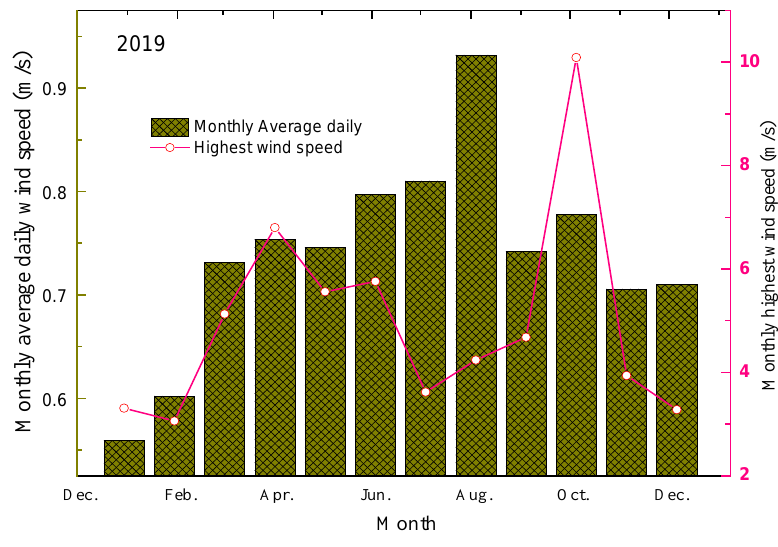
Figure 6. Monthly average daily wind speeds at the experimental site.